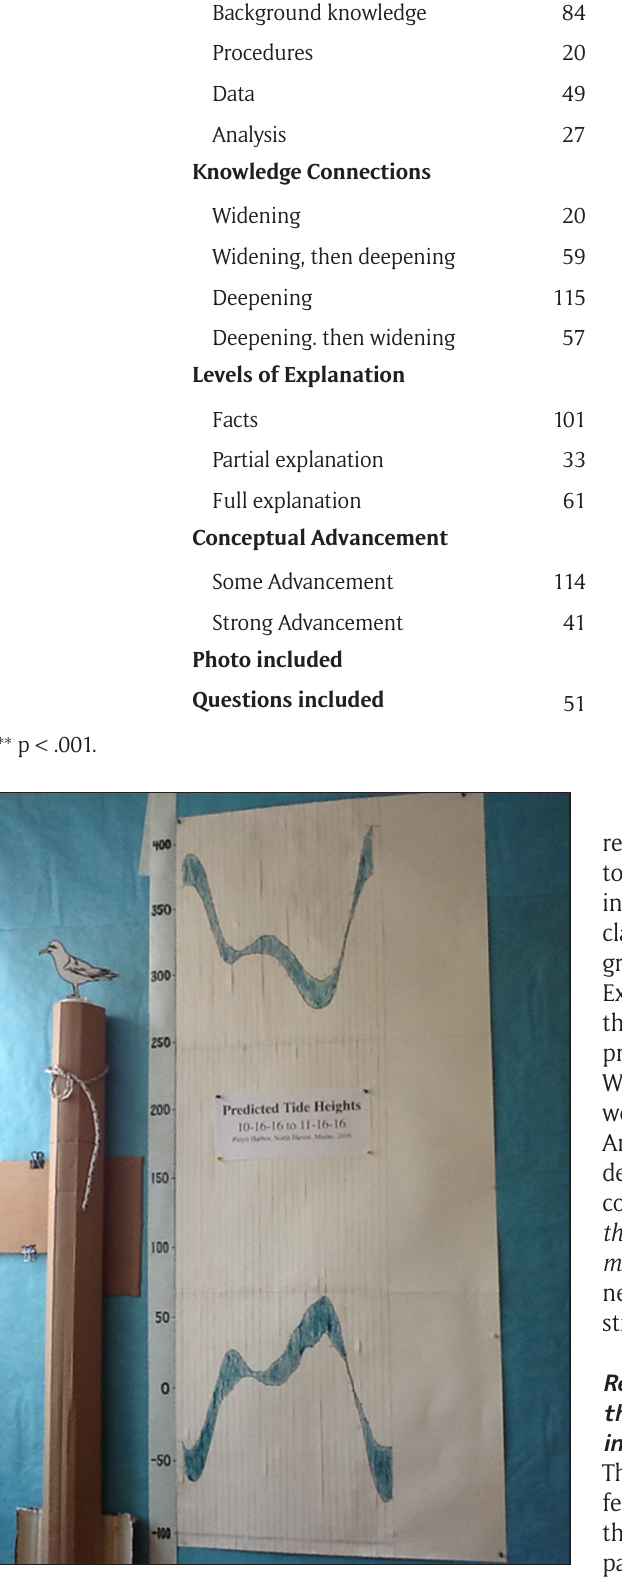
Figure 1: Sample of student graph used to widen and then deepen online